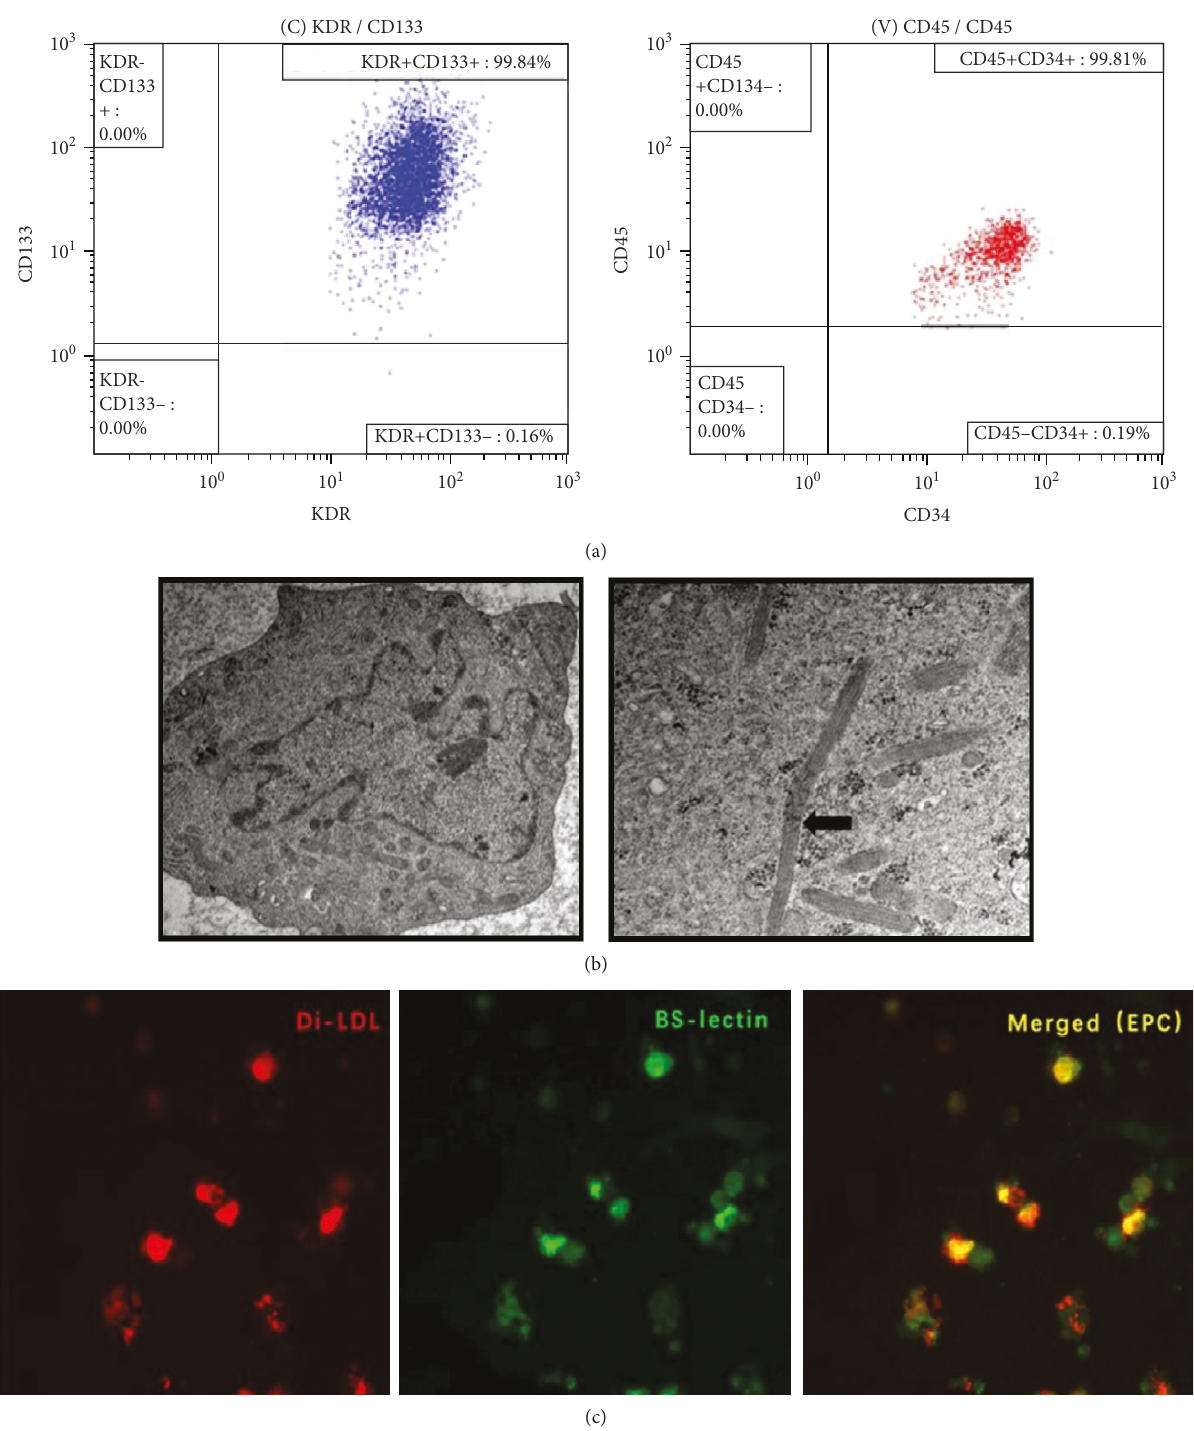
Figure 2: Characterization of endothelial progenitor cells (EPCs). (a) On day 7, after culture, EPCs were stained with antibodies against KDR, CD133, CD34, and CD45 and analyzed by fl ow cytometry. More than 99% of the cultured cells were positive for KDR, CD133, CD34, and CD45. (b) Ultrastructure of EPCs by electron microscopy. Black arrow shows a Weibel-Palade body, which is a structural characteristic of EPCs. Magni fi cation: (left) × 5000, (right) × 30000. (c) Endothelial progenitor cells were labeled with Dil-ac-LDL and stained with FITC-labeled BS-lectin. Double-positive cells were considered EPCs. Magni fi cation: ×